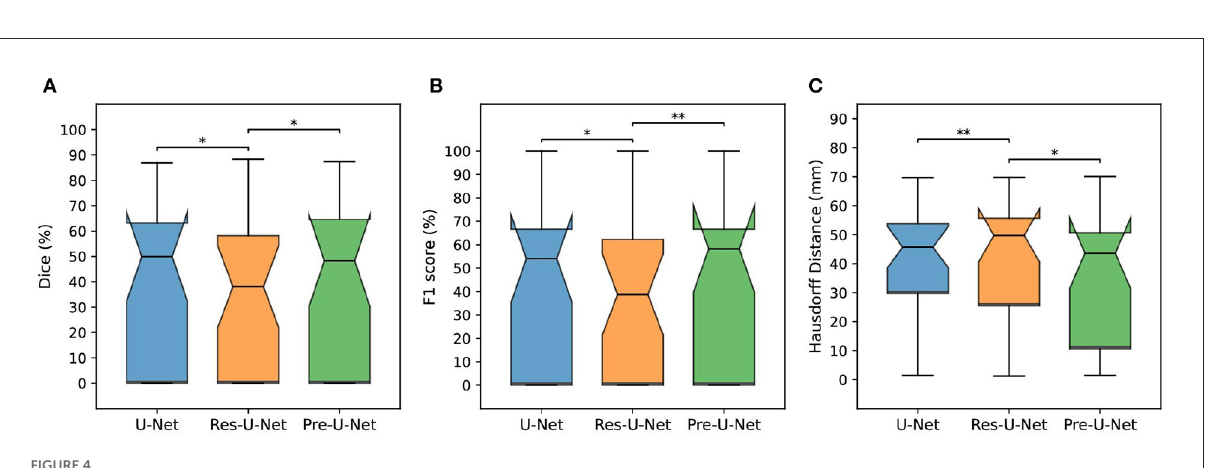
FIGURE4 Comparison of different models on the MSSEG-2 test set. (A–C) Show box plots of Dice score (%), F1 score (%), and Hausdorff Distance (mm), respectively. The asterisks indicate how significantly a model score differs from those of the other baselines when using a pairwise